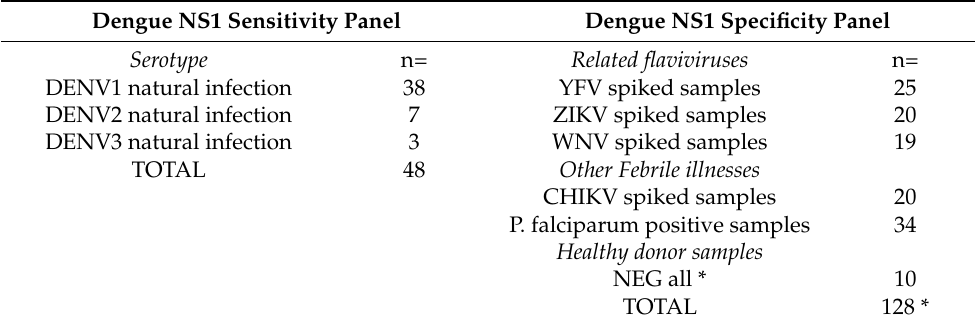
Table 1. Dengue NS1 sensitivity and specificity panel.